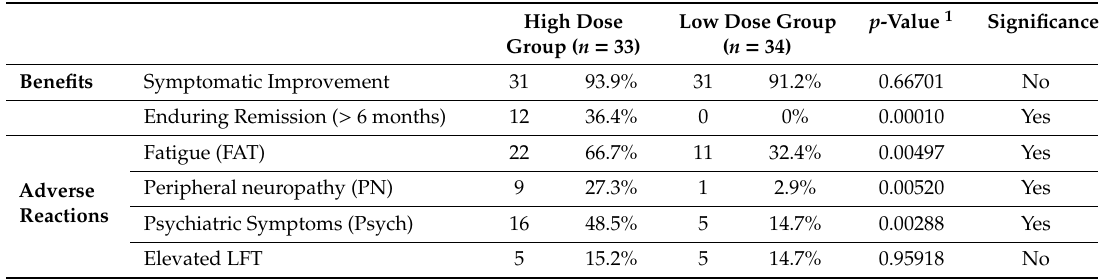
Table 3. Risk-benefit comparison between the two disulfiram treatment